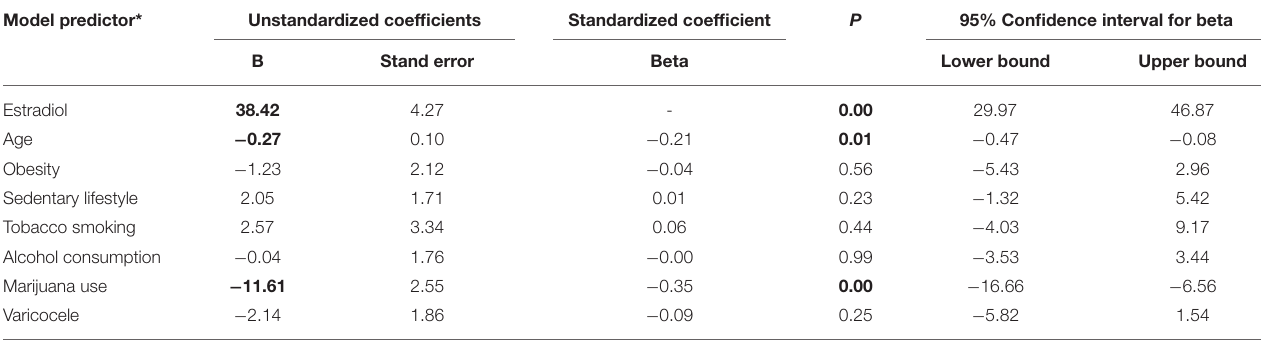
TABLE 4 | Coefficients of the multiple linear regression analysis model for dependent variable Estradiol. Model predictor* Unstandardized coefficients Standardized coefficient P 95% Confidence interval for beta Stand error Beta Lower bound Upper bound